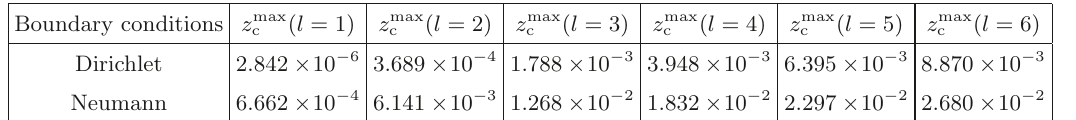
Table 2 . Marginally-stable spinning exotic compact objects. We present the largest dimensionless ( l ) ≡ ( r max − r + ) /r + (see eqs. (4.1) and (4.2)) of the horizonless reflecting compact radii z max c c objects with dimensionless angular momentum parameter ¯ a = 0 . 5 that can support static equatorial ( l = m ) scalar field configurations. One finds that the critical radii { z max